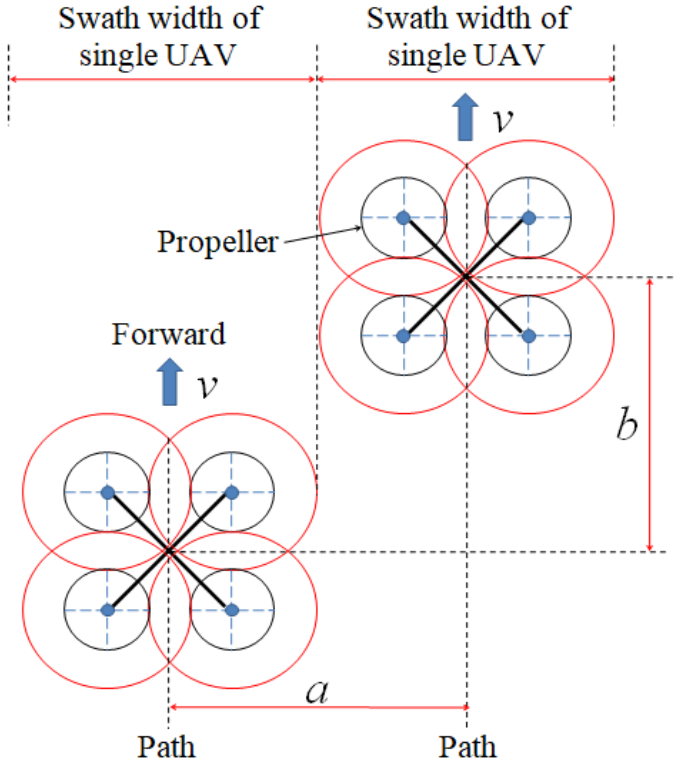
Figure 3. Parameters of dual-UAV formation flight.